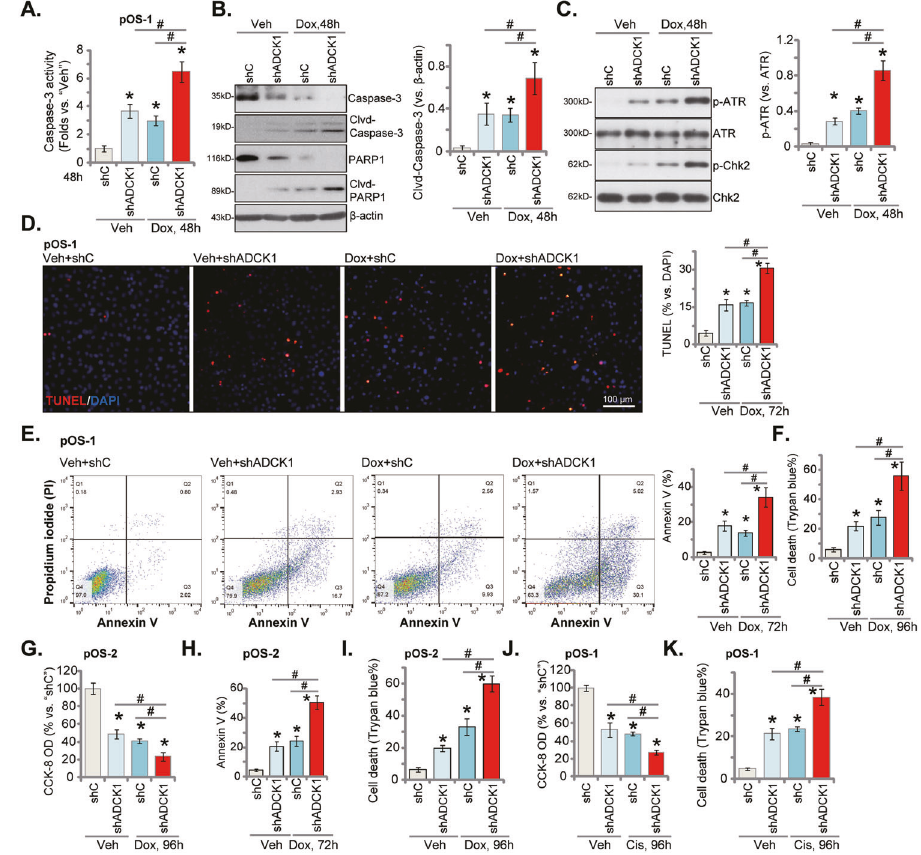
Fig. 5 ADCK1 silencing sensitizes doxorubicin-induced apoptosis in primary OS cells. The pOS-1 ( A – F ) and pOS-2 ( G – I ) primary cells, expressing the lentiviral ADCK1 shRNA ( “ shADCK1 ” ) or the lentiviral scramble control shRNA ( “ shC ” ), were treated with doxorubicin (Dox, 2 μ g/ mL) or vehicle control ( “ Veh ” ) for the designated hours, caspase-PARP1 activation was tested ( A , B ); Expression of listed DNA damage proteins was shown ( C ); Cell apoptosis and death were tested by the nuclear TUNEL staining/Annexin V FACS ( D , E , H ) and Trypan blue staining ( F , I